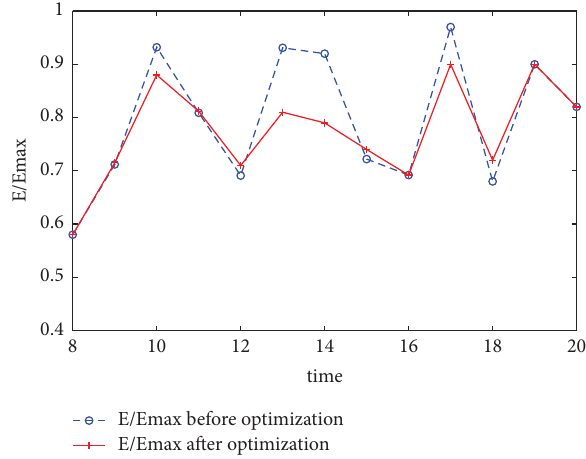
Figure 18: E / E max before and after optimization.